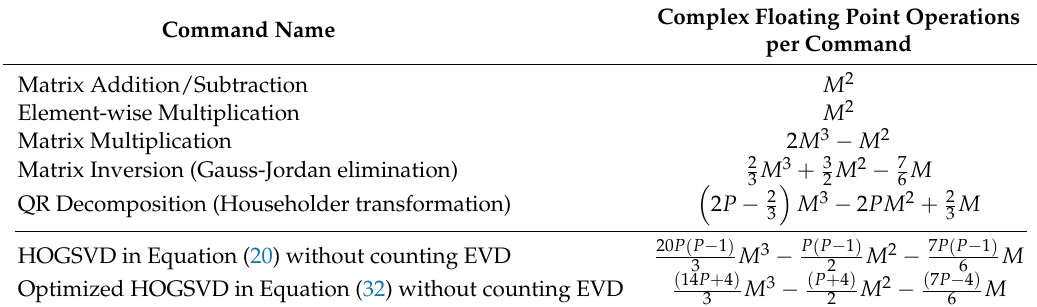
Table 2. Computational